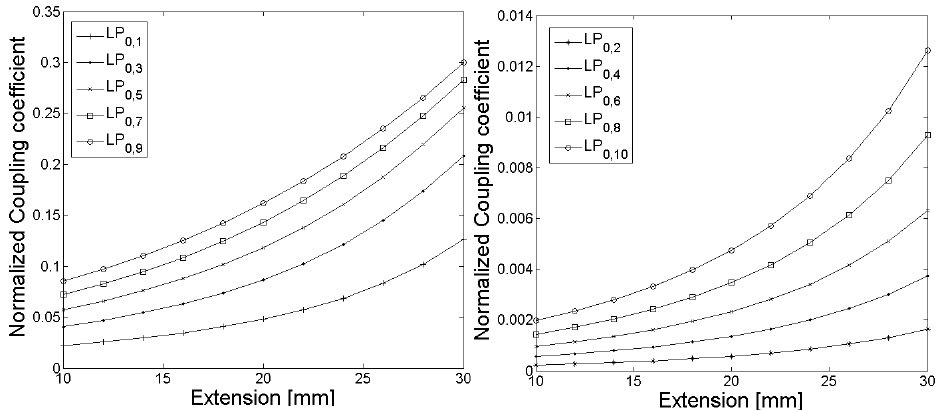
Figure 4. The normalized coupling coefficients as a function of the fiber extension l during the tapering process for coupling of light from the fundamental LP 0,1 core mode to the LP 0,1 –LP 0,10 cladding modes of the SM1500 fiber with a starting cladding diameter of 125 μ m are shown, whereby modes with odd mode numbers ( left ) have significant larger normalized coupling coefficients compared to the modes with even mode numbers ( right ).